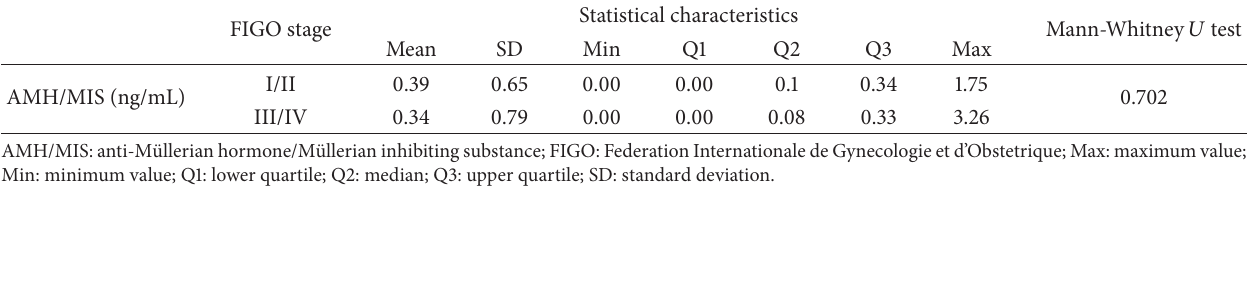
Table 3: AMH concentration in relation to grading.